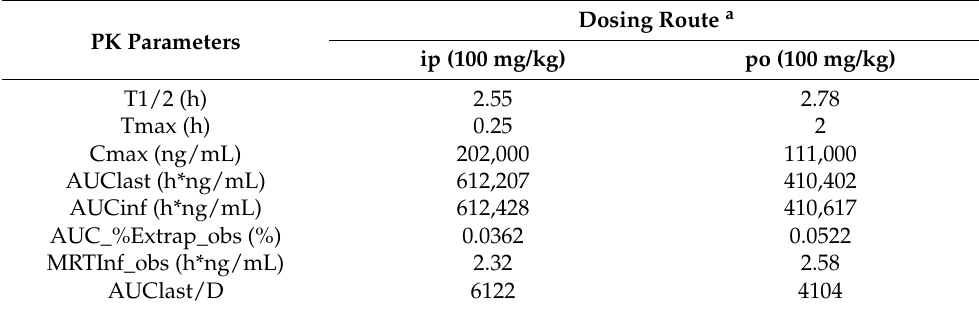
Table 5. Results of in vivo pharmacokinetic studies. PK